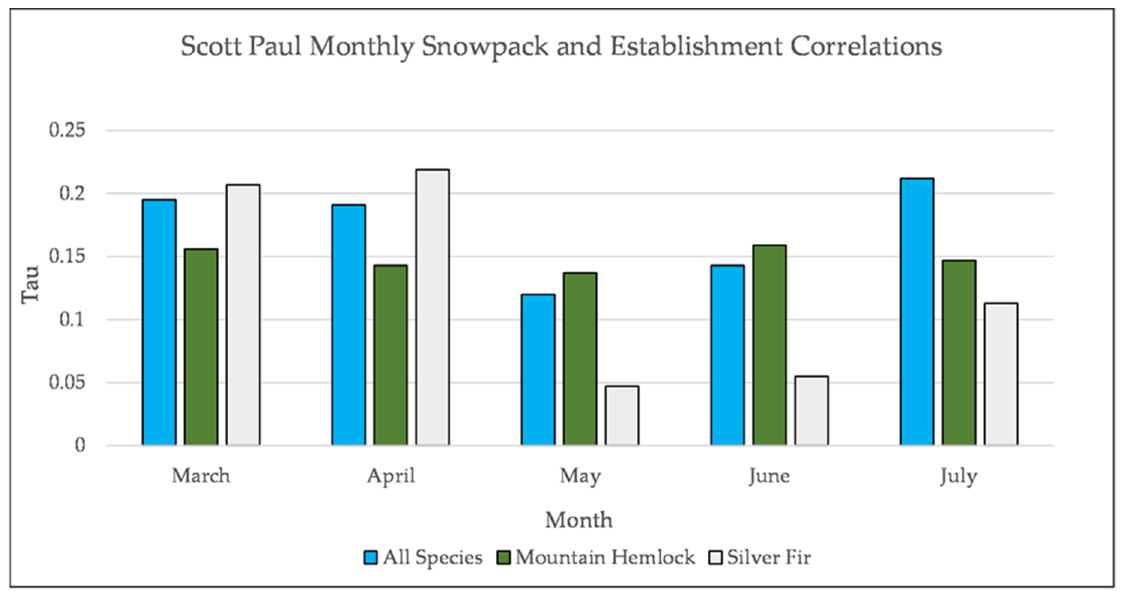
Forests 2021 , 12 , x FOR PEER REVIEW Figure A14. Partial Kendall’s correlation controlled for temperature between mean monthly snowpack and establishment at Scott Paul. None of these correlations are significant.